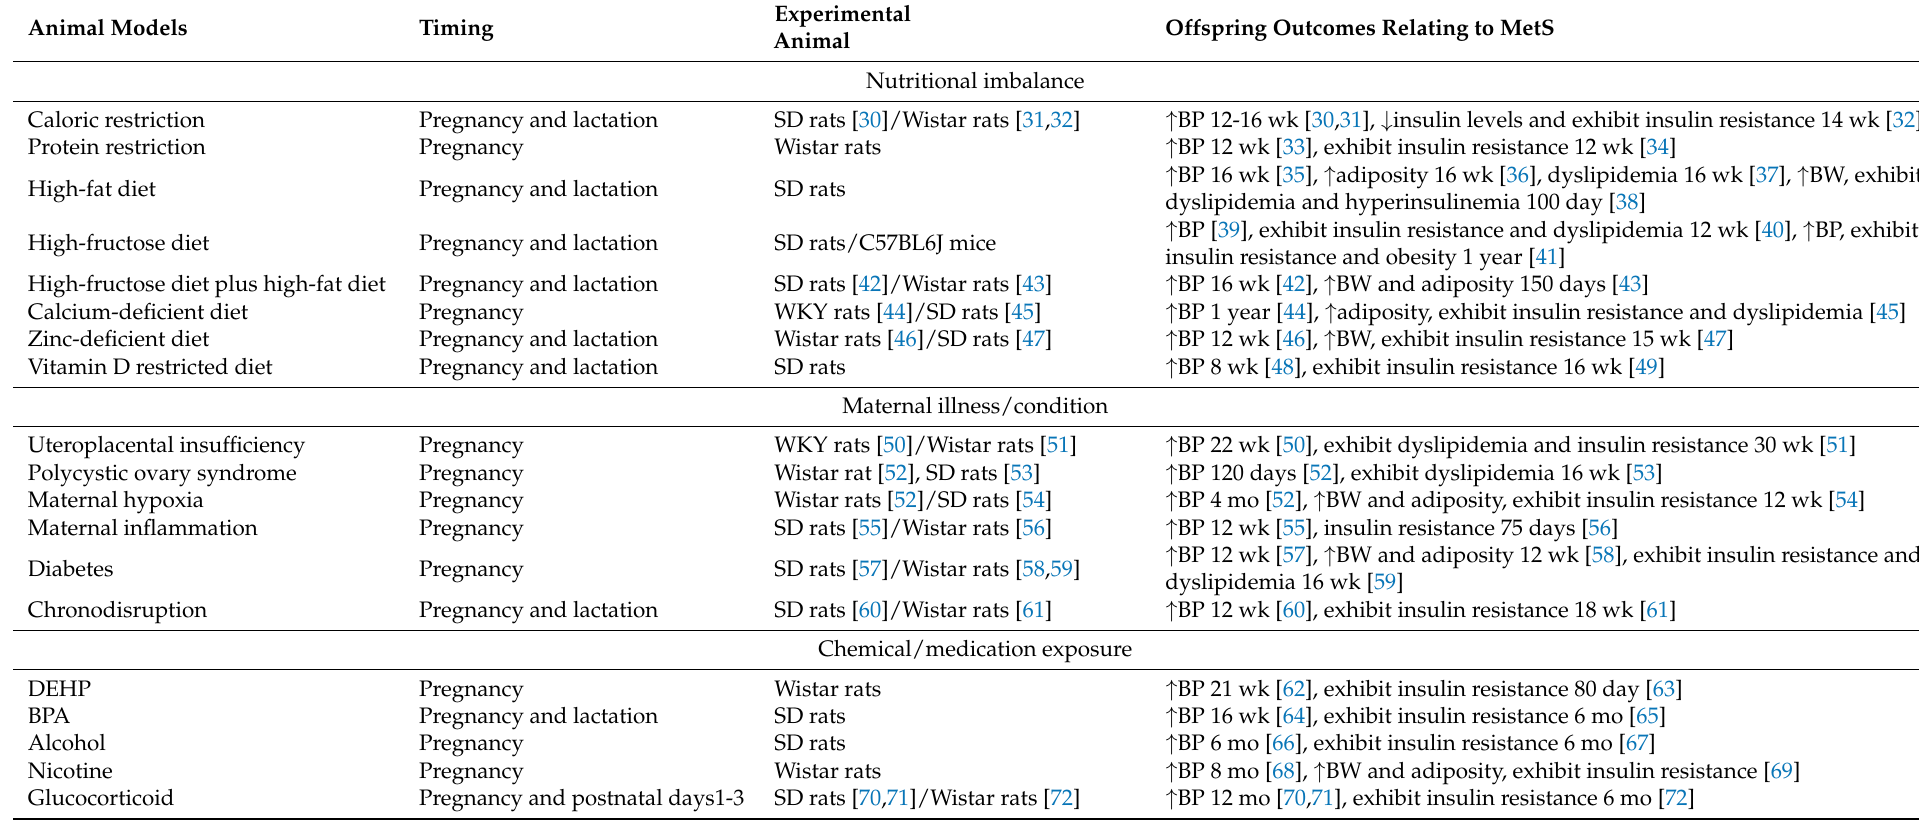
Table 1. Rodent models of MetS of developmental origins, categorized according to environmental